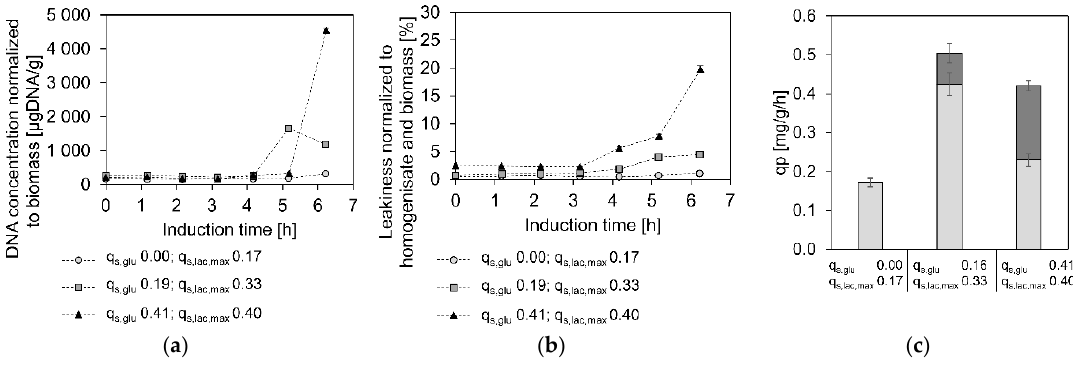
Figure 2. Leakiness, lysis and productivity at different q s,glu /q s,lac,max ( a ) Lysis normalized to biomass at the different q s,glu and correlating q s,lac,max values: black triangles indicate values for q s,glu = 0.41 g/g/h q s,lac,max = 0.40 g/g/h, grey squares represent q s,glu = 0.19 g/g/h q s,lac,max = 0.33 g/g/h, light grey circles are values obtained from the lactose batch experiment. ( b ) Leakiness normalized to biomass: Black triangles indicate values for q s,glu = 0.41 g/g/h q s,lac,max = 0.40 g/g/h, grey squares represent q s,glu = 0.19 g/g/h q s,lac,max = 0.33 g/g/h, light grey circles are values obtained from the lactose batch experiment. ( c ) specific overall, intracellular (light grey), and extracellular (dark grey) product formation rates for the q s,glu and correlating q s,lac,max values.